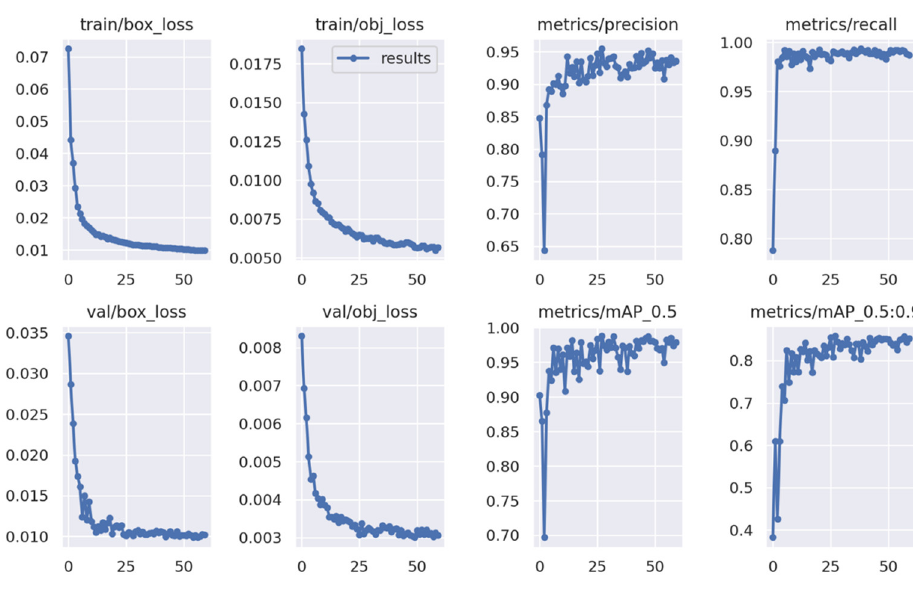
Figure 13. Training progress of the YOLOv4 object detection algorithm using the Darknet framework.